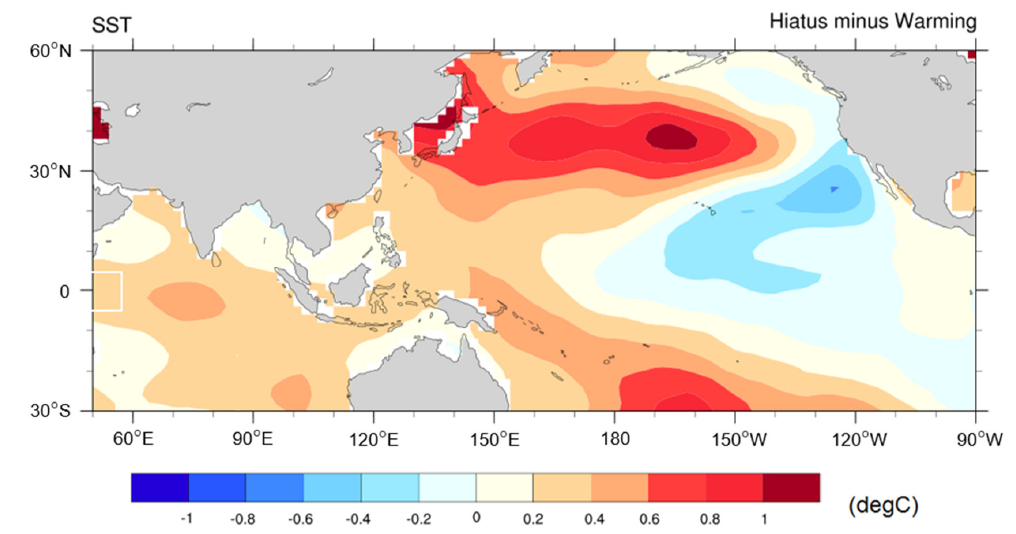
Figure 17. SST anomaly between hiatus period (1998–2013) and warming period (1976–1997). The unit is